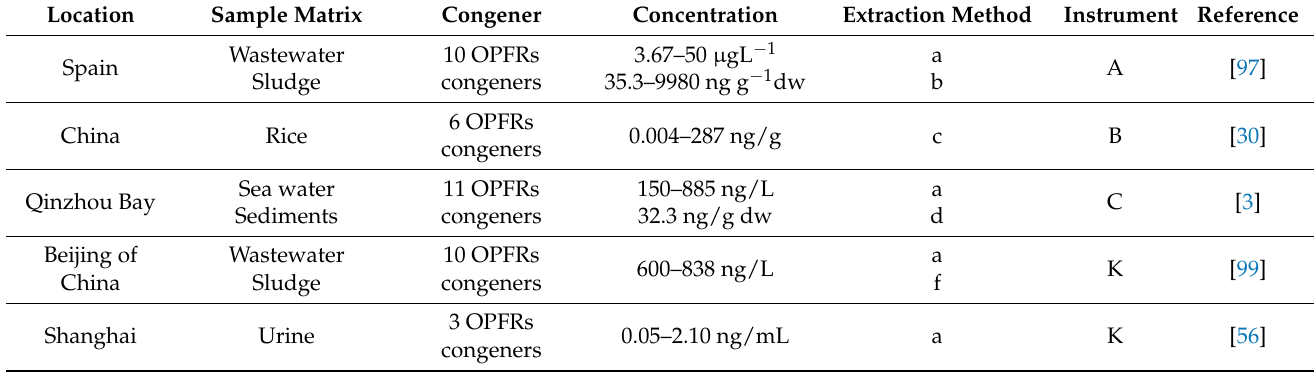
Table 6. Reported OPFR levels around the world from different matrixes using different extraction techniques and different analytical